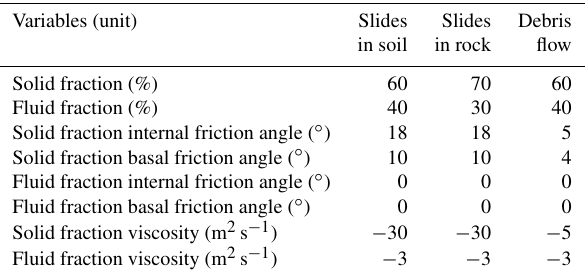
Table 1. R.avaflow parameters for slides in soil, slides in rock, and debris flow run-out